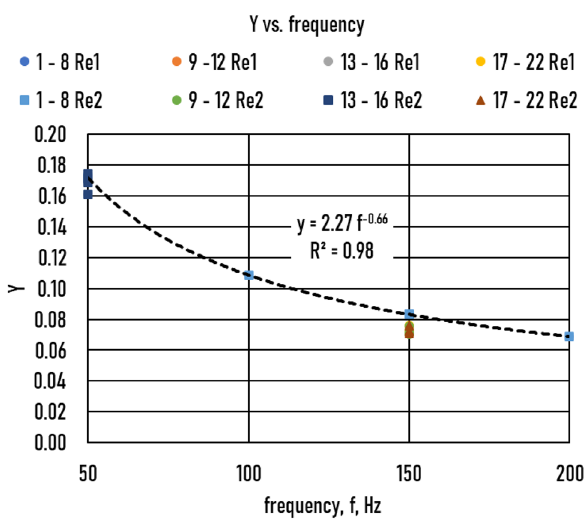
Figure 11. Y vs. frequency of all the samples. Reynolds number ( Re1 = 3220, Re2 =